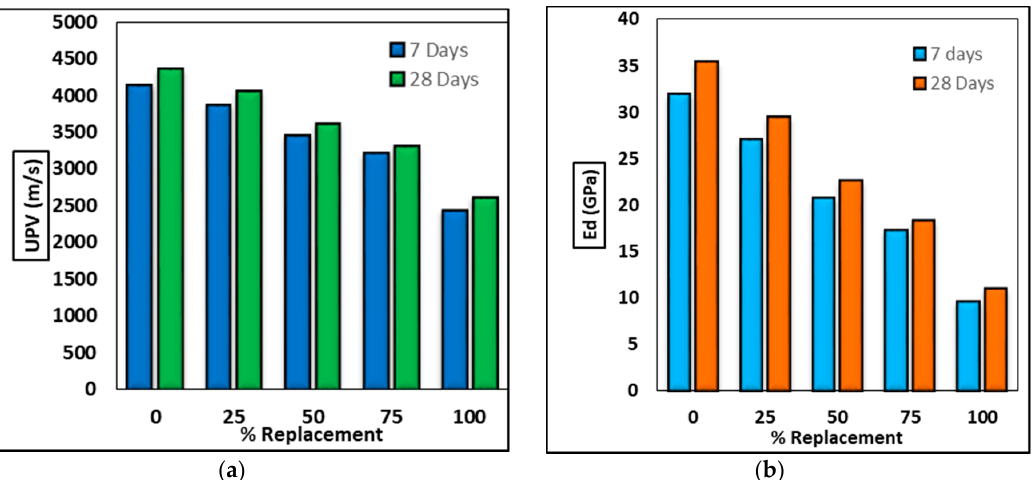
Figure 5. Non-destructive testing: ( a ) % replacement of carbon black effect on UPV and ( b ) dynamic modulus of elasticity (GPa).